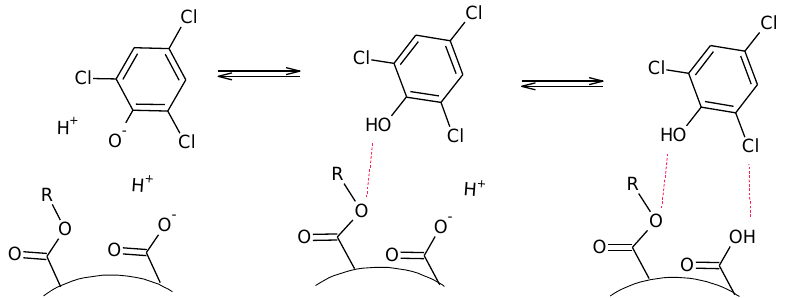
Figure 9. Scheme of the acid-base equilibria at the oil-based polymer and the phenols solution in- terface.